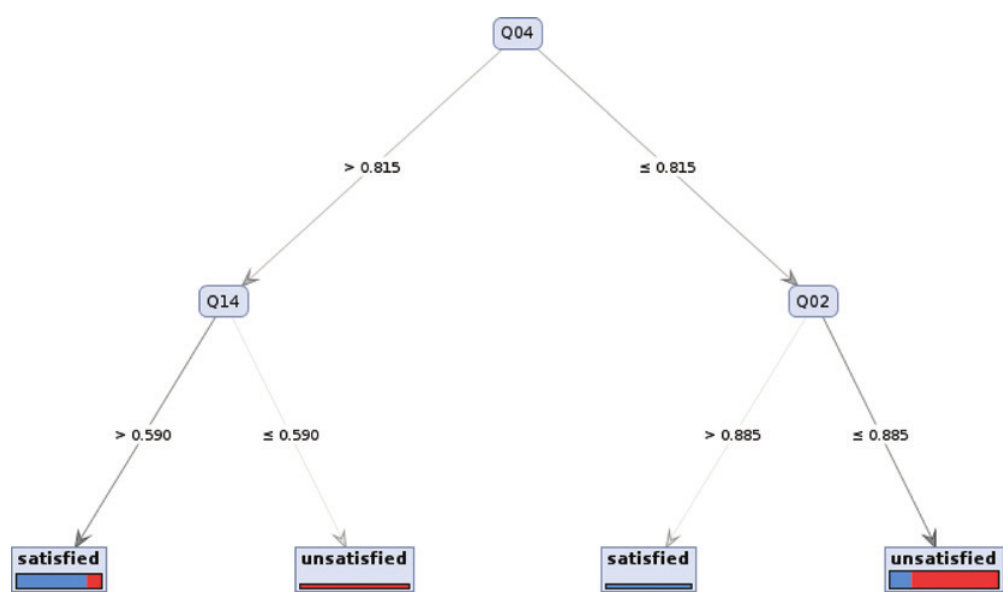
Figure 6: AI-generated tree model showing how Q22 satisfaction can be predicted from other NSS questions, in computer science, across all